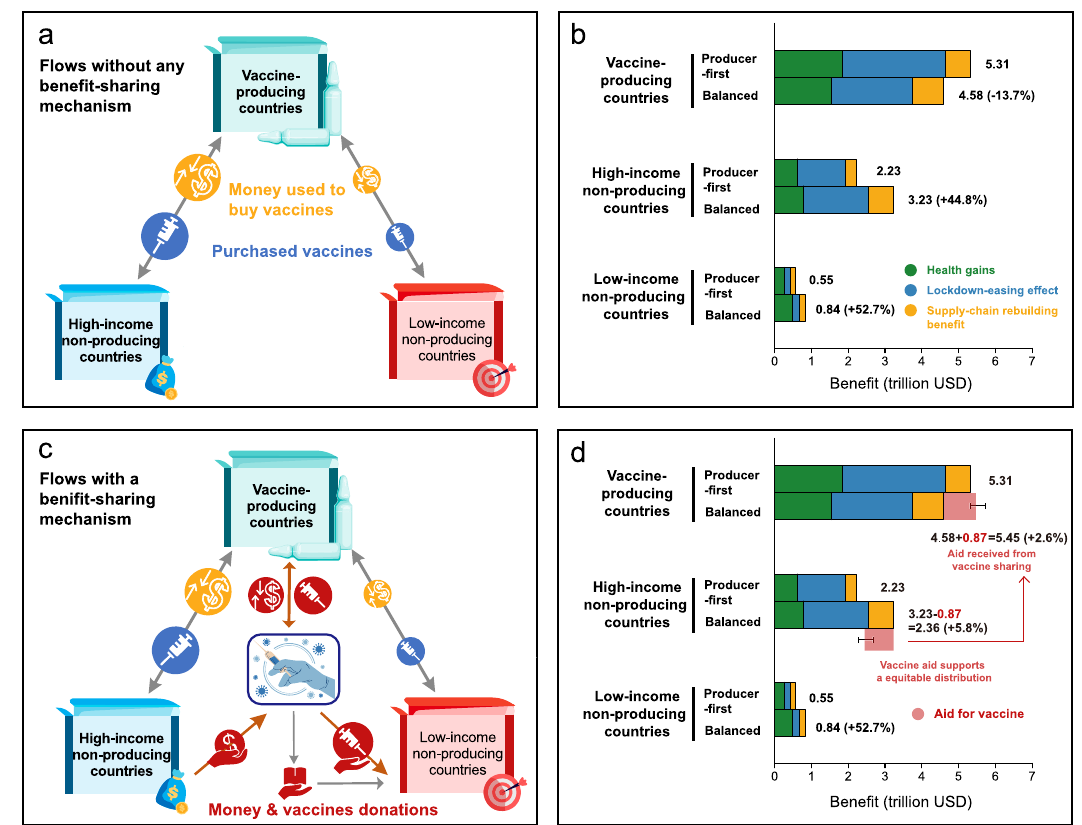
Fig. 3 | Vaccination-related bene fi ts of three groups under different global vaccine-distribution strategies and the potential incentives (i.e., multilateral bene fi t-sharingmechanism)topromoteamoreequitabledistribution.a Shows fl ows of money and vaccines without any bene fi t-sharing mechanism; b shows the bene fi ts of the three groups of countries without any bene fi t-sharing mechanism; c shows fl ows of money and vaccines with a bene fi t-sharing mechanism; d shows the new situation (payoffs of the three groups of countries under different dis- tribution strategies) with a bene fi t-sharing mechanism. The yellow money symbol in ( a , c )indicates moneyused tobuyvaccines and the bluevaccine symbolin( a , c )